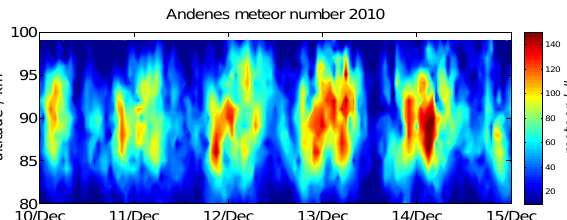
Fig. 1. Time series of total meteor counts per altitude for the period 10 to 14 December 2010, measured with the Andenes SKiYMET meteor radar. Peak activity on the night from 13 to 14 December, with almost equal activity on the night before. Note the strong de- crease in total meteor counts in the night from 14 to 15